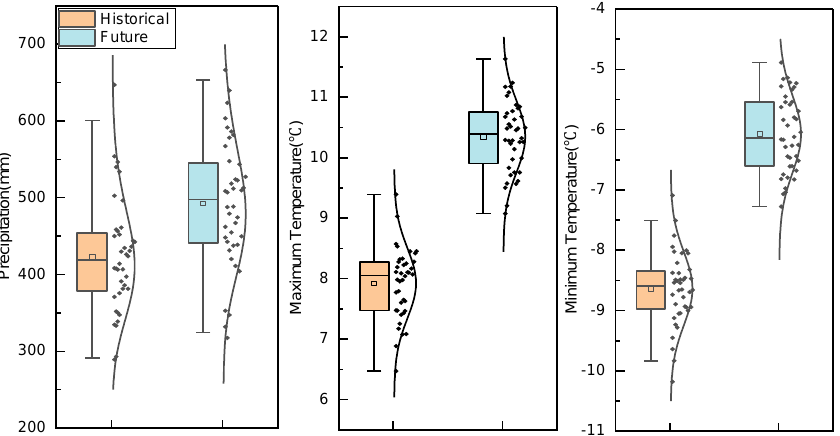
Figure 5. Box plot of historical and future temperatures and precipitation in the study area.